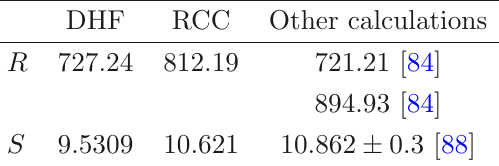
Table 1 . DHF and RCC results for the EDM enhancement factors R , and the S-PS coupling constants S of the atomic EDM of 210 Fr using the DC Hamiltonians, calculated using the RCCSD method. S values are given in units of 10 − 18 e cm. These values are compared against previous calculations by ref.